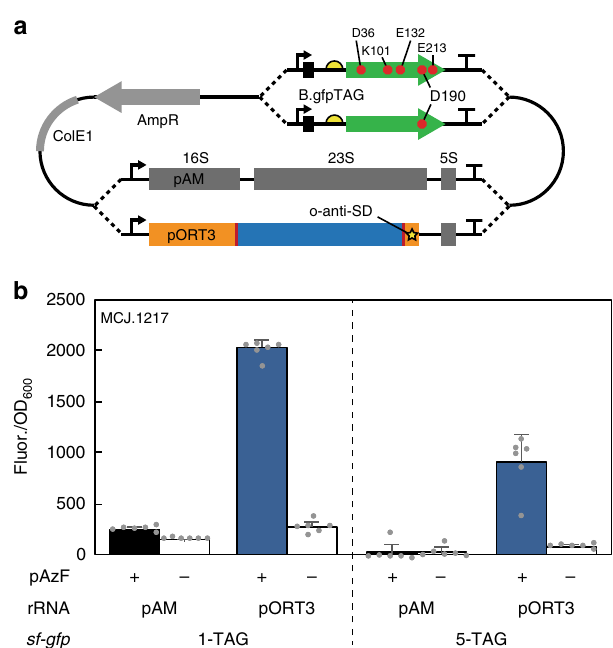
Fig. 6 Incorporation of ncAA p-azido- L -phenylalanine (pAzF) by orthogonal Ribo-T. a Combined rRNA and sf-gfp plasmid with sf-gfp gene is replaced with a 1TAG or 5TAG version to create pORT3B.gfp1TAG and pORT3B. gfp5TAG (orthogonal Ribo-T with ASD sequence 3 and orthogonal sfGFP message B containing 1 TAG or 5 TAG, respectively). Wild-type rrnb operon was cloned as a negative control for background orthogonal expression (pAM.B.gfp1TAG and pAM.B.gfp5TAG). b Expression of sf-gfp with 1TAG or 5TAG in C321. Δ A derived strain MCJ.1217 (C321. Δ A.mutS + . Δλ red. Δ upp), in the presence of ( + ) or absence of ( − ) pAzF. Error bars = 1SD of n = 6 independent experiments. Source data for b can be found in the Source Data fi